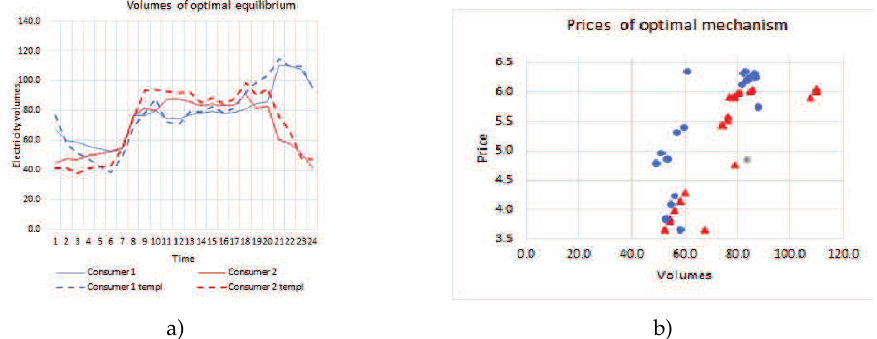
Figure 6. The maximum welfare pricing. The optimal load (a) and prices (b).